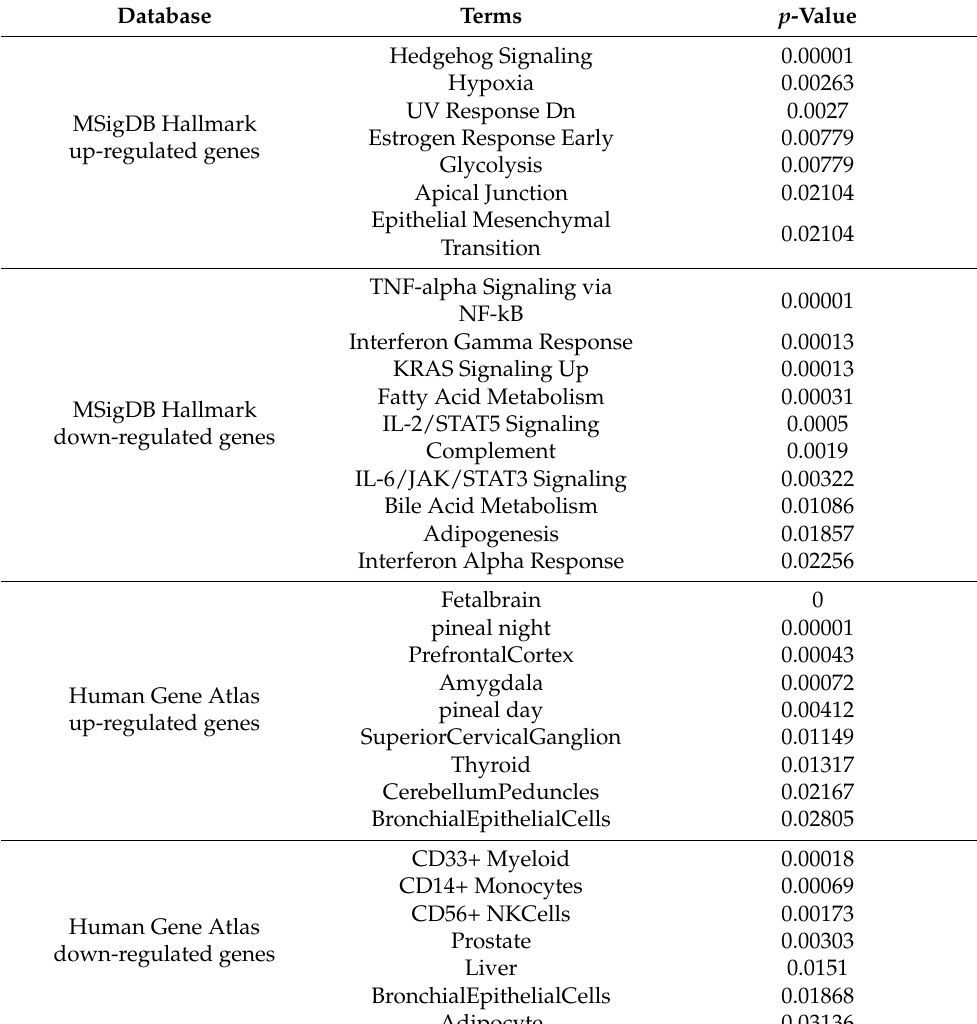
Table 2. Over-representation analysis by Enrich tool.